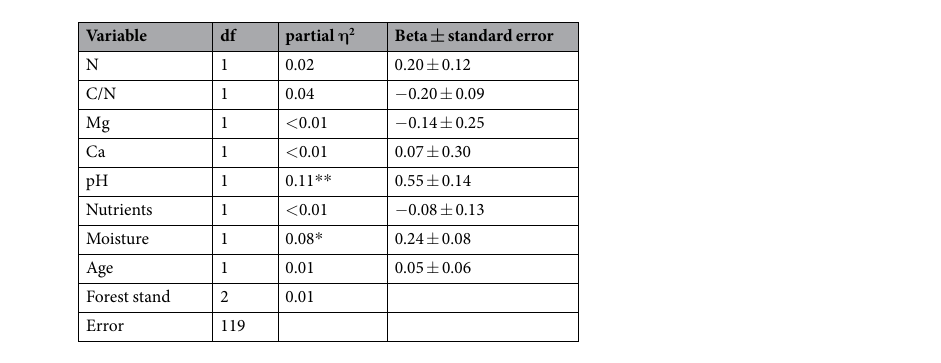
Table 1. Generalized linear modelling pointed to pH, moisture, and to a lesser degree C/N ratio as main predictors of plot ln-transformed species richness. Moisture and pH refer to respective Ellenberg scores. Parametric Bonferroni corrected (nine single tests) significance levels: * P(F) < 0.05, ** P(F) < 0.01. Whole model r 2 = 0.24, P <